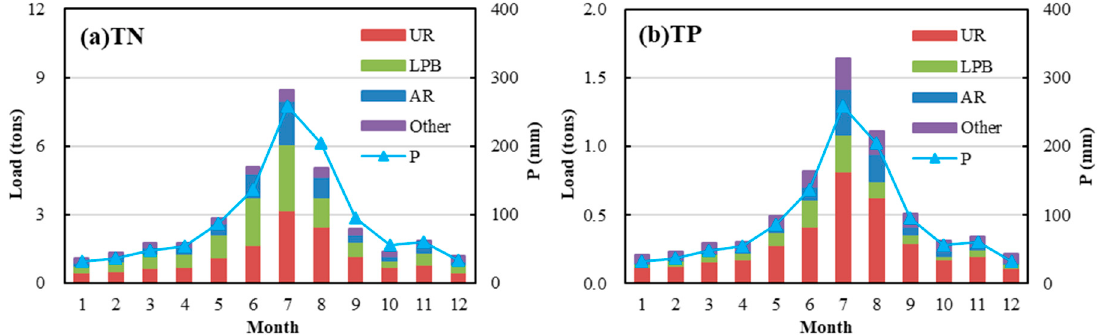
Figure 10. Monthly average pollution emissions of each type of land use into rivers.